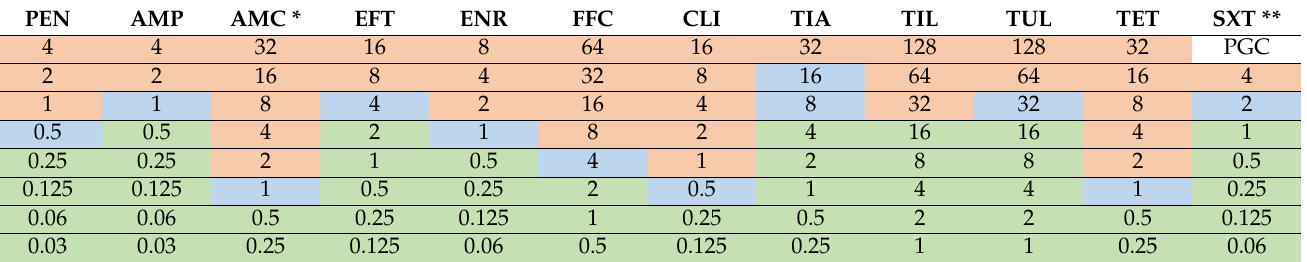
Table 3. The set for the antimicrobial susceptibility testing of S. suis with tested concentrations (mg/L) of antimicrobials, and the breakpoints